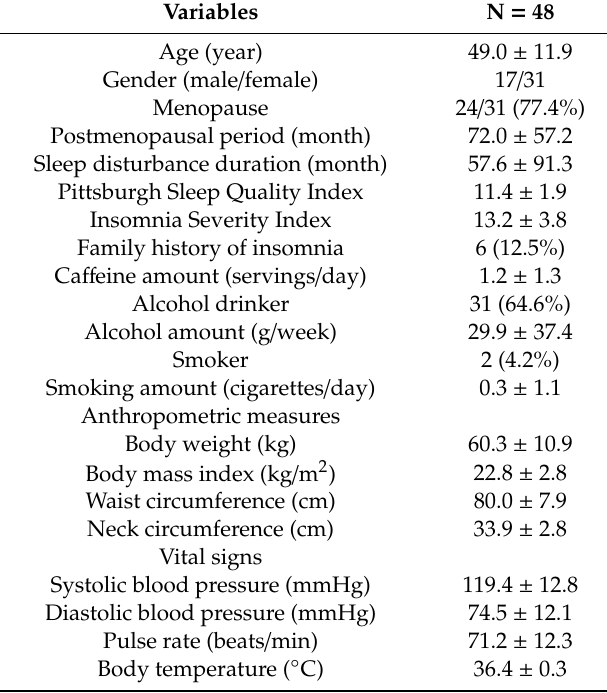
Table 1. Demographic characteristics of